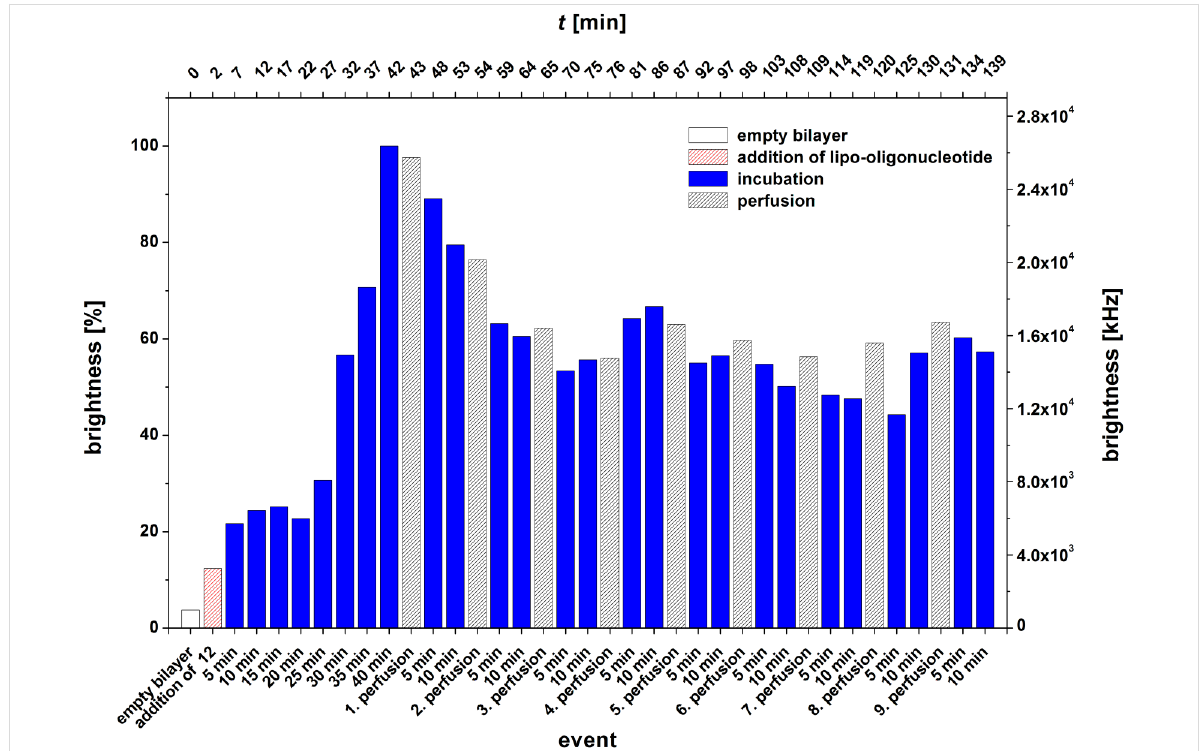
Figure 7: Bilayer brightness vs event graph of 5’-d( 6a -Cy5-TAG GTC AAT ACT) ( 12 ).